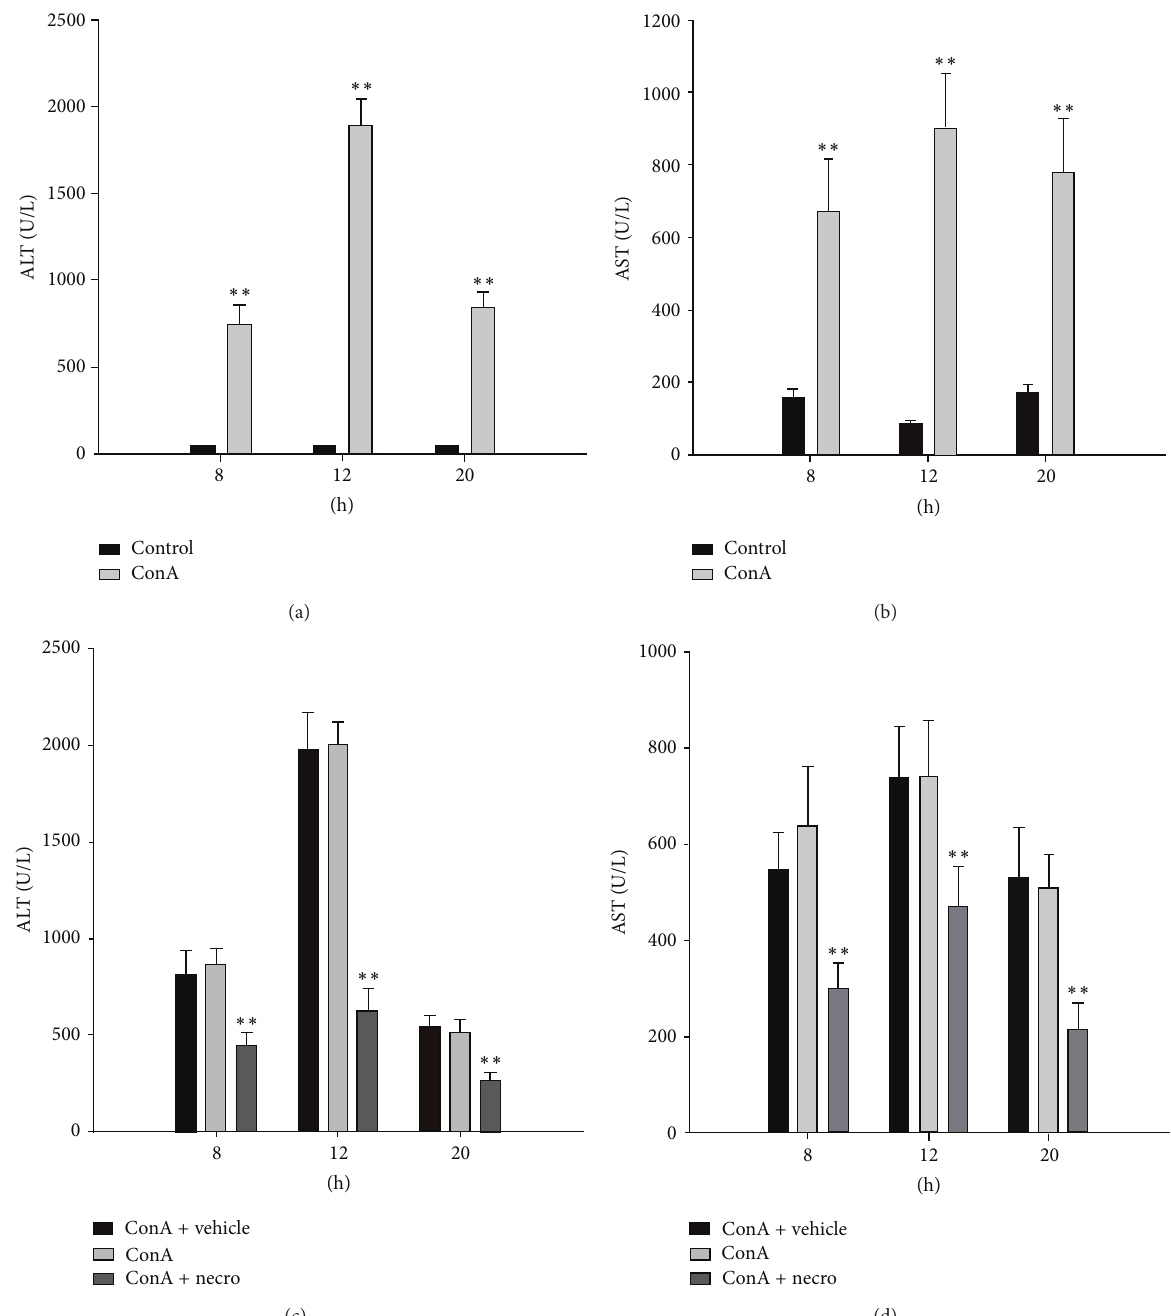
Figure 1: Induction of liver injury by ConA in model mice and Nec-1-treated mice. ((a)-(b)) Plasma ALT and AST levels in mice at 8, 12, and 20h after ConA injection. Data are expressed as means ± SD ( 𝑛 = 10 mice, ∗∗ 𝑃 < 0.01 ). ((c)-(d)) Serum ALT and AST levels were measured at 8, 12, and 20h after ConA injection in the vehicle-treated, control, and Nec-1-treated mice. Each value is a mean ± SD ( 𝑛 = 10 mice, ∗∗ 𝑃 < 0.01